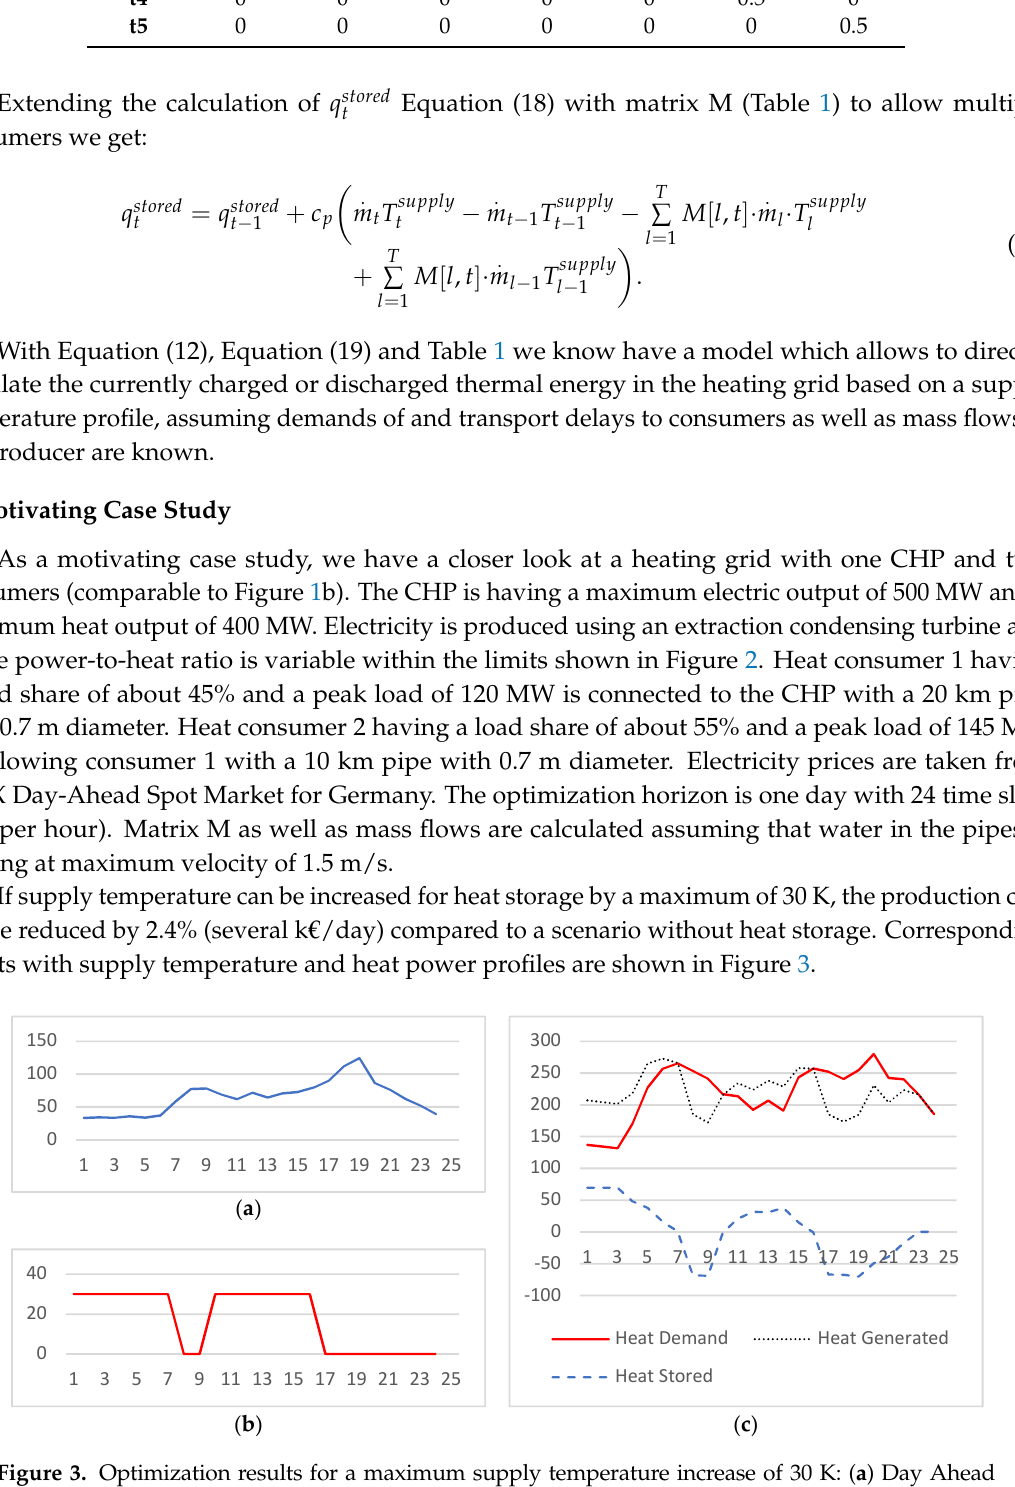
Table 3. Variation of objective induced by parameter variations for a maximum supply temperature increase of 30 K. Parameter Variation